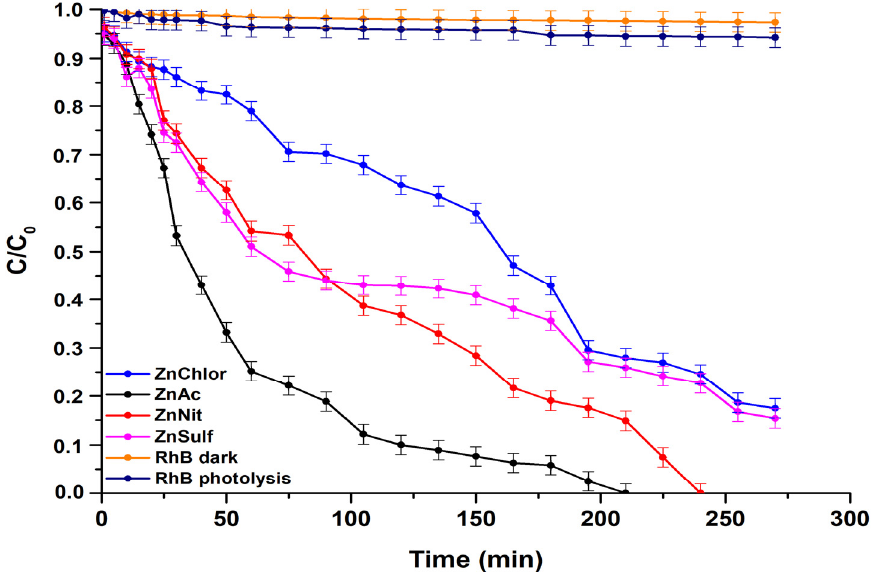
Figure 10. Real time UV–Visible spectra under UV photocatalytic degradation of Rhodamine B, by the four ZnO powders, produced by different precursors.